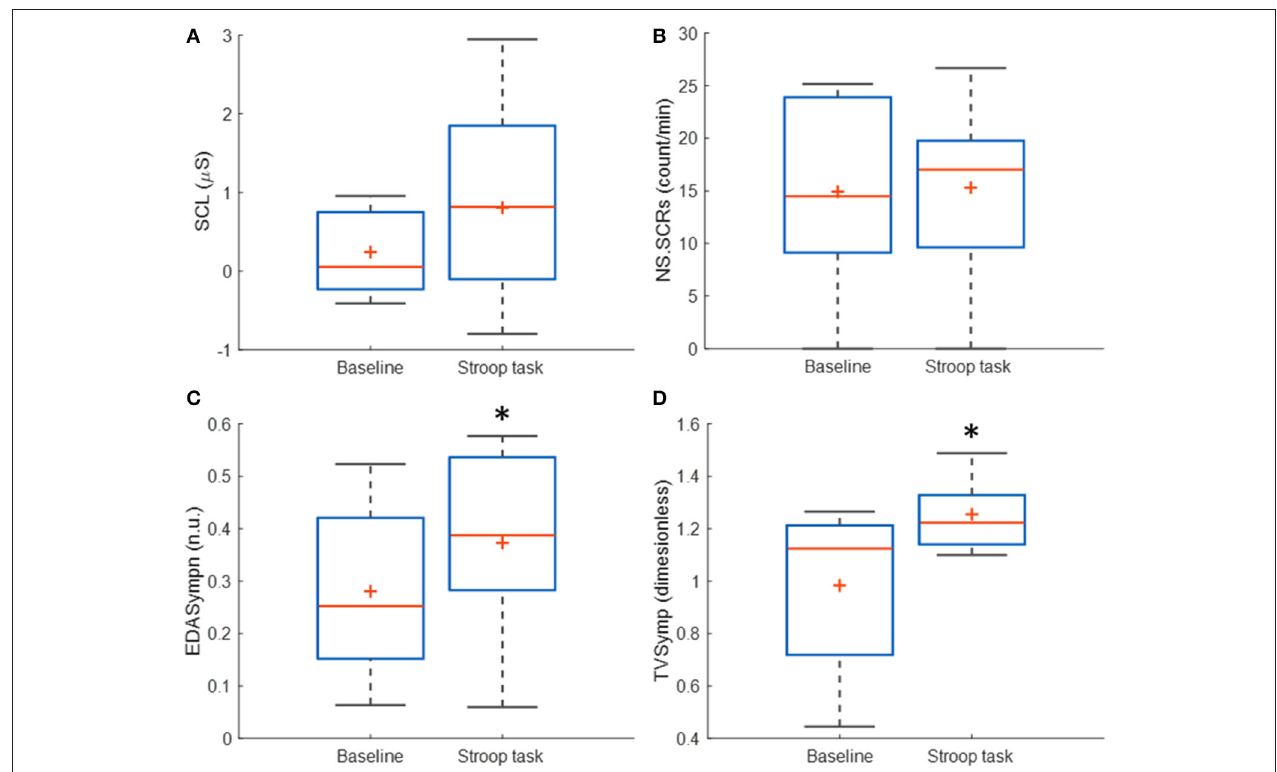
FIGURE 3 | Box plots of the time-domain and frequency-domain measures of EDA for baseline and Stroop task stages, for N = 14 subjects immersed in water. (*) Represent significant differences between stages. (A) SCL, skin conductance level; (B) NS.SCRs, non-specific skin conductance responses; (C) EDASympn, normalized power spectra in the 0.045 to 0.25Hz band; (D) TVSymp, time-varying index of